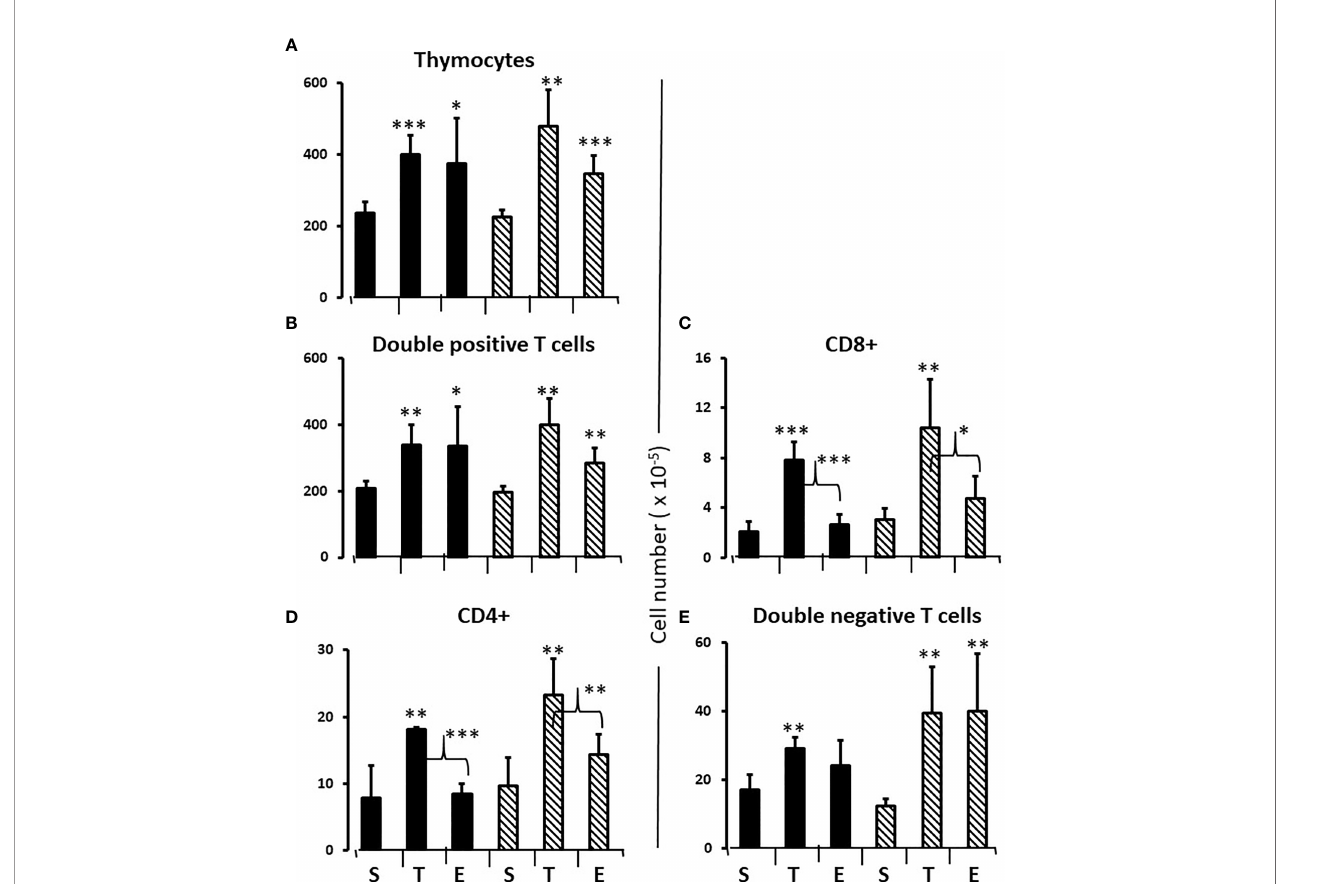
FIGURE 8 | Effect of testosterone and estradiol on cell numbers in the thymus. FCG Mouse pups were treated between days 1 and 7 postpartum before collection of tissues. Data are derived from gated lymphocytes, presented as the mean ± SD, and are derived from 6 males and 5 females in the control group, 3 males and 3 females in the testosterone group and 5 males and 7 females in the estradiol group. S, sesame oil control; T, testosterone; E, estradiol. Males include both XYM and XXM (solid bars) and females include both XXF and XYF (cross-hatched bars). Brackets show difference between included bars, with the asterisk designating the degree of signi fi cance for these and those compared to same sex control *p < 0.05; **p < 0.01; ***p <